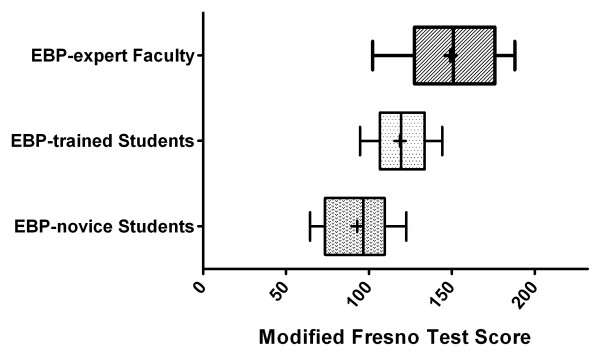
Modified Fresno Test scores by group. Box and whisker plot of modified Fresno Test scores for EBP-novice PT Students (n = 31), EBP-trained PT Students (n = 50), and EBP-expert PT Faculty (n = 27). The central box spans from the lower to the upper quartile, the middle line represents the median, the '+' sign represents the mean, the whiskers extend from the 10th percentile to the 90th percentile of scores. Analysis of variance for linear trends was p < 0.0001.